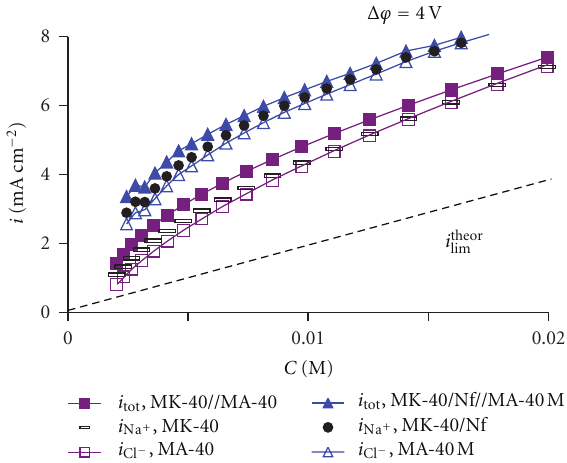
Figure 5: Total ( i tot ) and partial current densities in the electro- dialysis cell shown in Figure 2 as functions of the feed NaCl con- centration. i Na + and i H + are the partial current densities of Na + and H + ions through cation-exchange membrane, respectively; i Cl − and i − and OH − ions through anion-exchange mem- OH − are those of Cl brane, respectively. The potential drop across the cell pair is